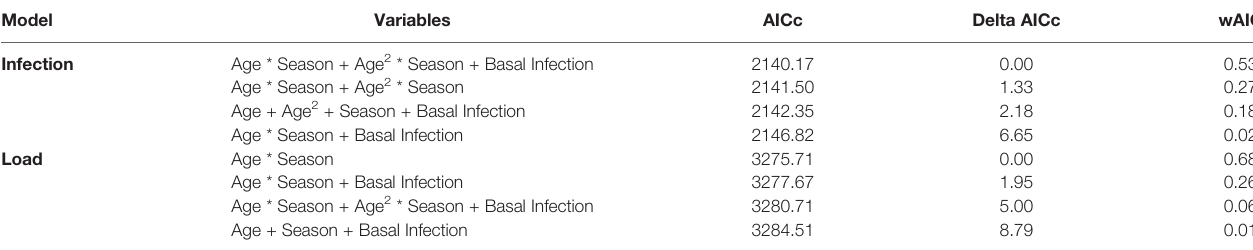
TABLE 2 | Results of model selection based on AICc for the probability of infection by N. ceranae and the N. ceranae load in adult bees. Model